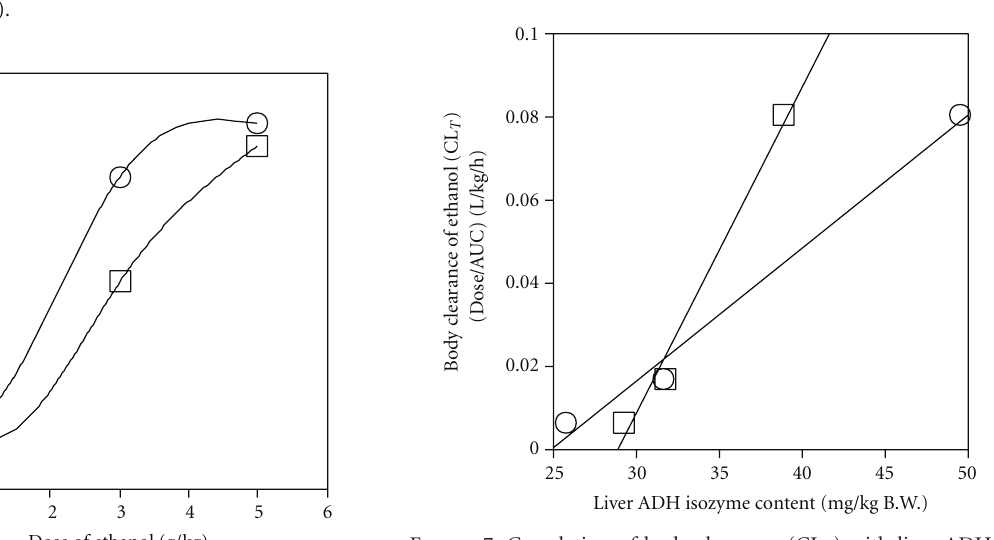
Figure 7: Correlation of body clearance (CL T ) with liver ADH 1 and ADH 3 contents. CL T value was from Figure 6. Liver ADH 1 ( (cid:2) ) and ADH 3 ( (cid:2) ) contents were from Figure